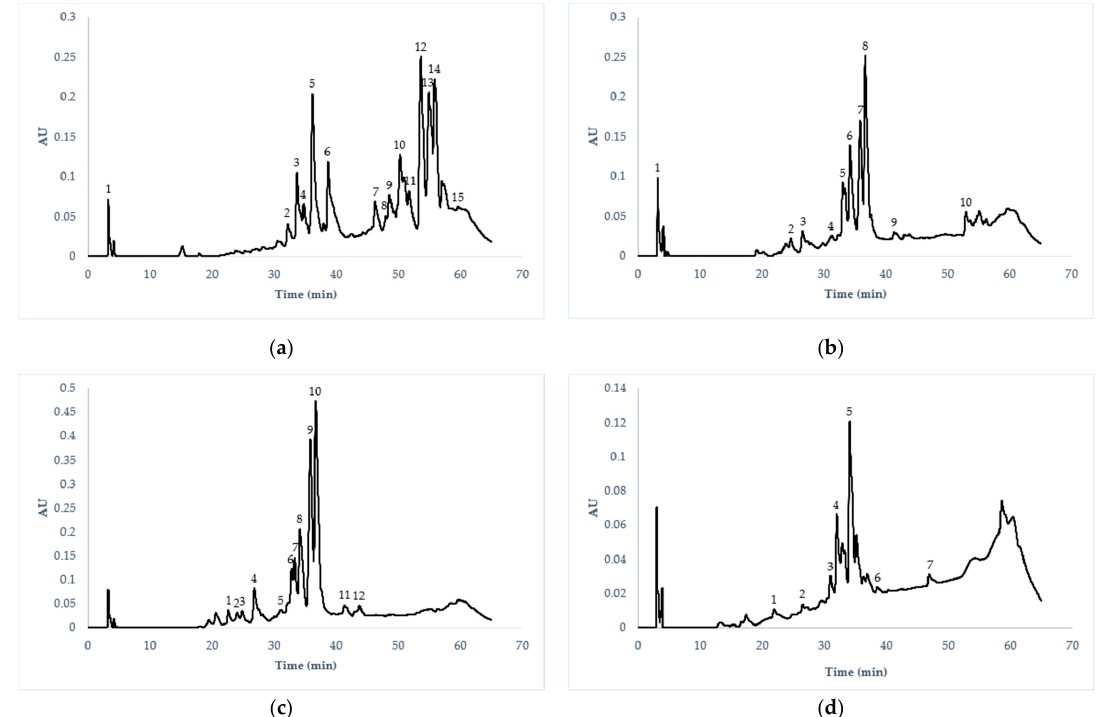
Figure 1. Chromatographic profiles of the main phenolic compounds of cactus flowers from Hidalgo, Mexico. ( a ) Cylindropuntia rosea (CA): (1, 10, 15) hydroxycinnamic acids, (5) anthocyanins, (2, 3, 4, 6, 12) flavonols, (7, 11, 14) hydroxybenzoic acids, (13) methoxyflavones, (9) proanthocyanidin trimers. ( b ) Opuntia oligacantha (XU): (1, 2, 3) methoxycinnamic acids, (4, 10) methoxyflavones, (6) flavonols, (7, 8) methoxyflavonols. ( c ) Opuntia matudae (XC): (1, 2) methoxycinnamic acids, (4) lignans, (5) methoxyflavones, (8) flavonols, (9, 10) methoxyflavonols, (12) anthocyanins. ( d ) Echinocereus cinerascens (PI): (1, 2) catechins, (3, 4, 5) flavanols, (7) methoxyflavonols.